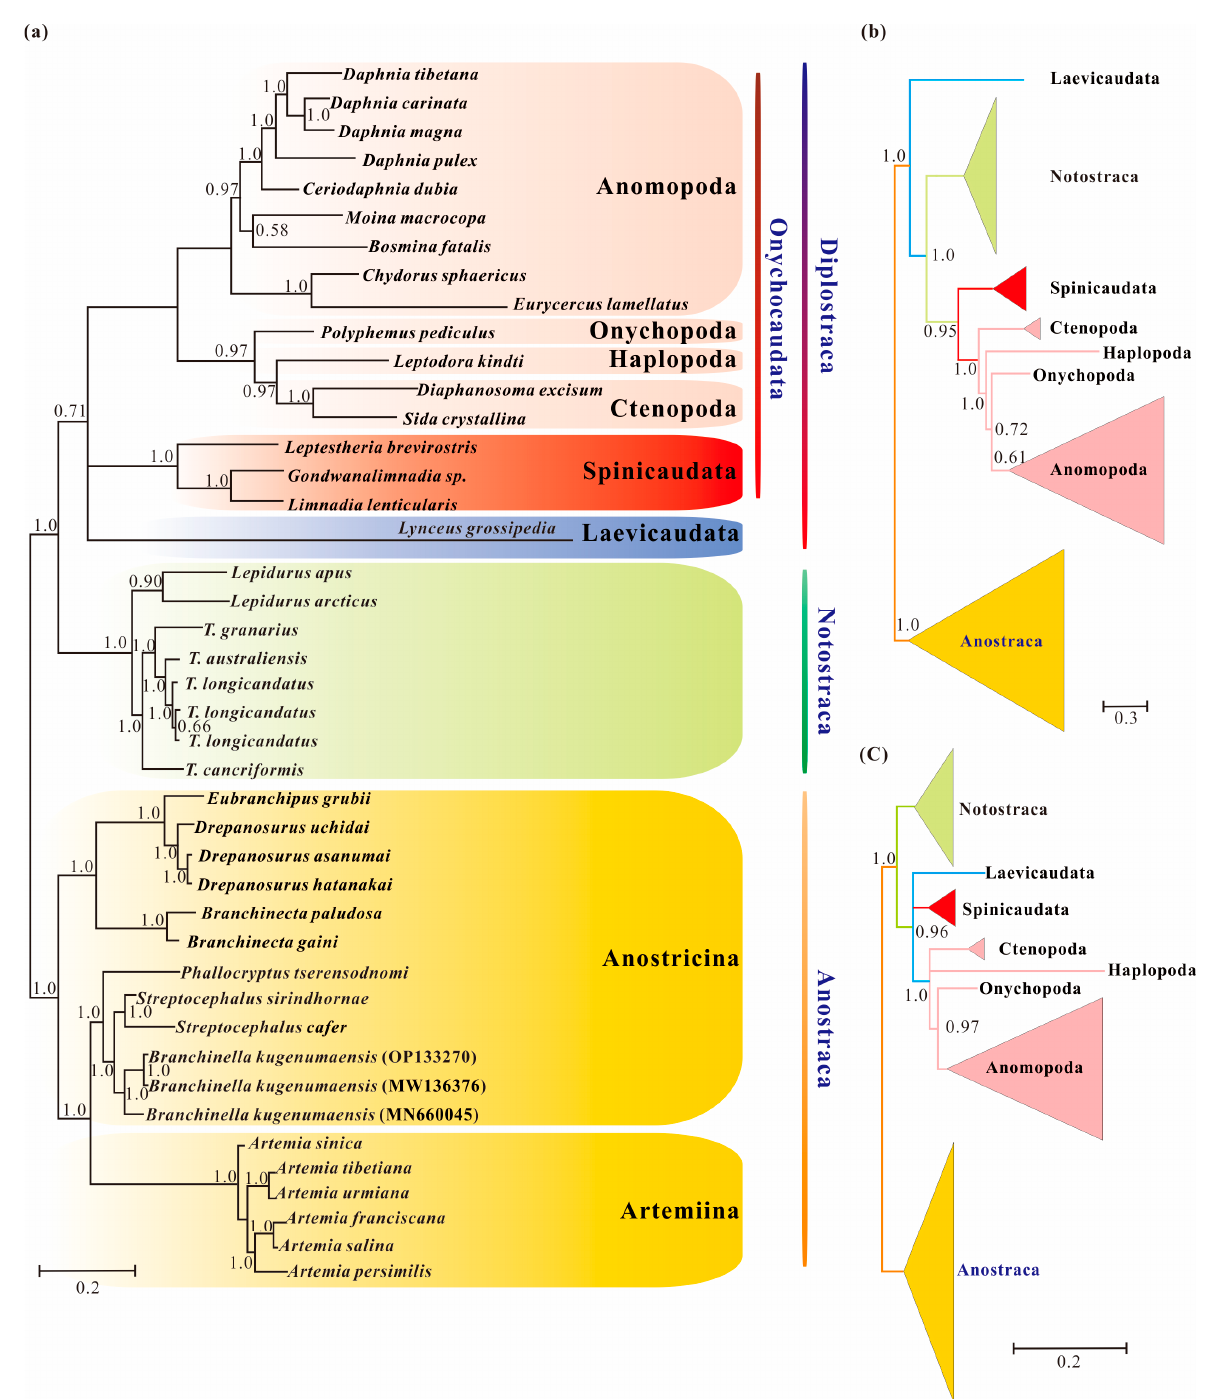
amino acid datasets exhibit incongruence by the monophyly of Onychocaudata. ( c ) and ( d ) are re- sults based on the PCG12 and PAA datasets respectively using the four-cluster likelihood mapping analyses. For each matrix, the sequences are divided into four clades: ( a ) Anostraca; ( b ) Notostraca; ( c ) Laevicaudata; ( d ) Onychocaudata. The corners of the triangles represent the three alternative topologies.